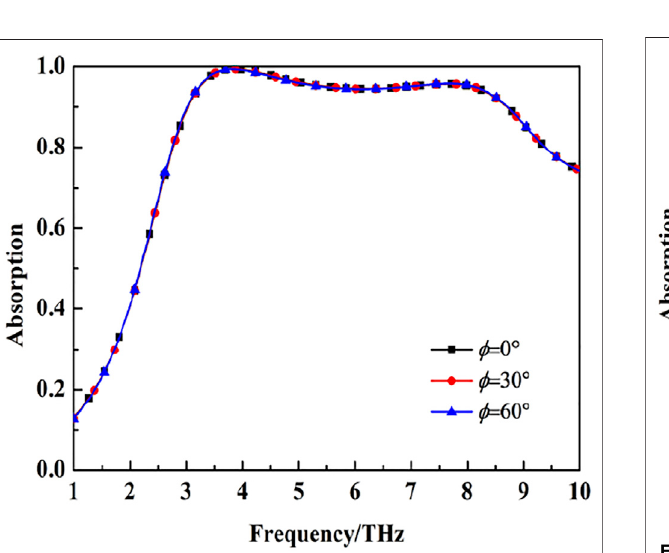
FIGURE 6 | The absorption of the metamaterial absorber at different polarization angles ( T (cid:1) 300 K).